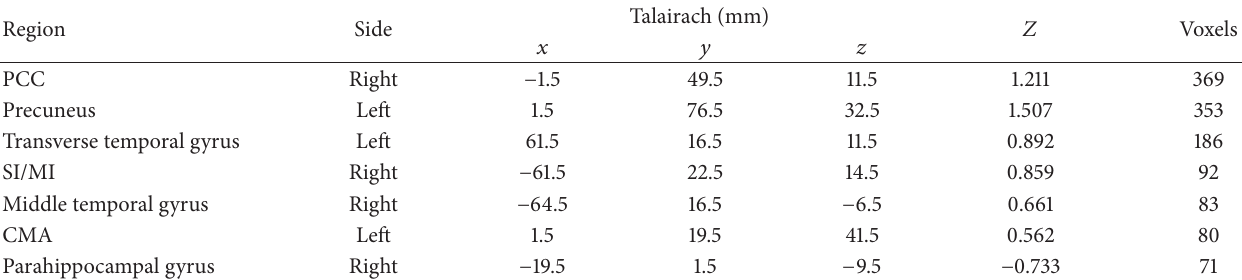
Table 2: Intergroup analysis of areas when making finger